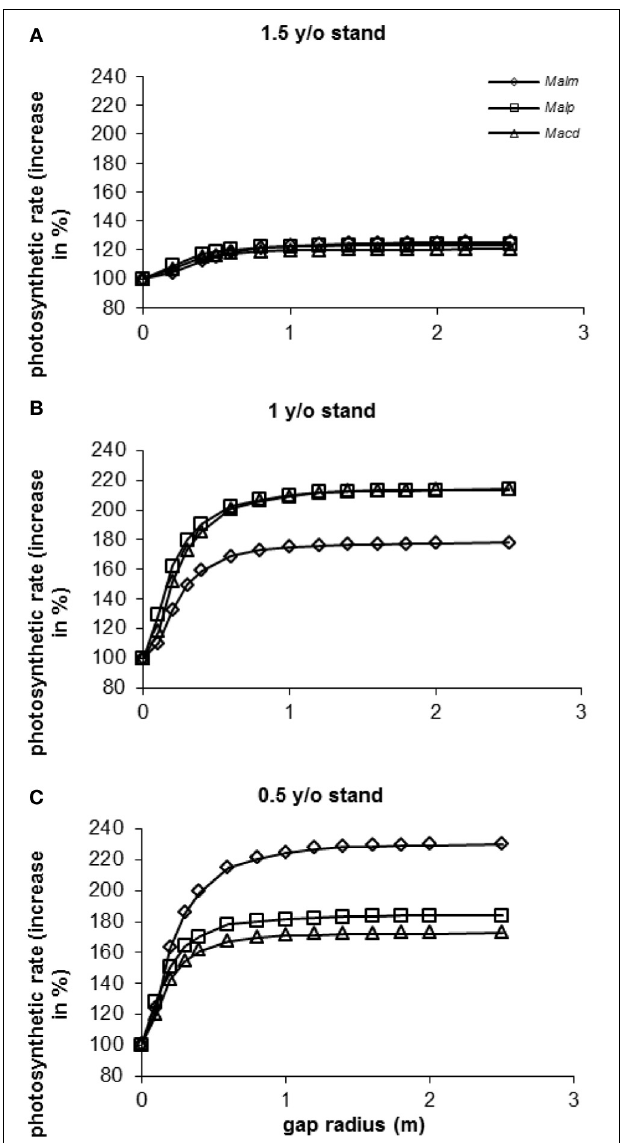
FIGURE 9 | (A–C) Model simulations of the effect of gap radius on whole canopy photosynthetic rates of species in three successional vegetation stands of the same forest. Simulations were done for individual trees [data were taken from Van Kuijk et al., 2008]. For abbreviations see Figure 3